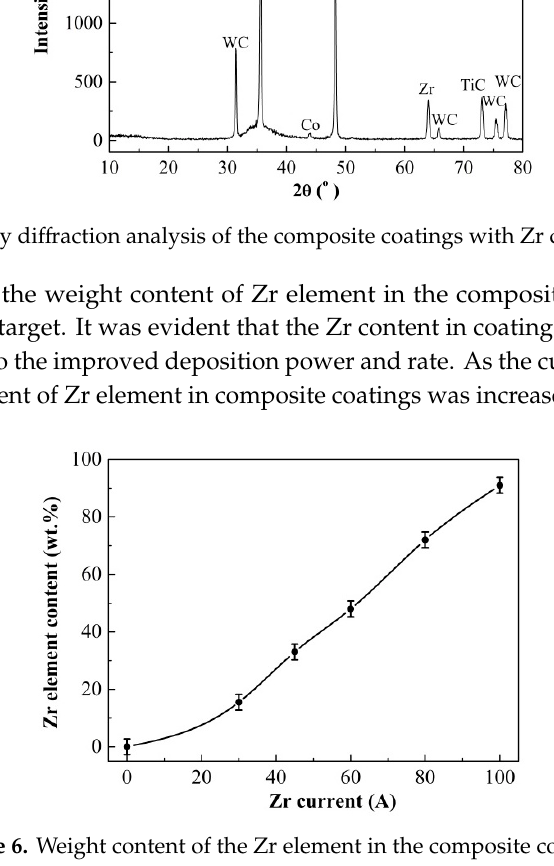
Figure 6. Weight content of the Zr element in the composite coatings.